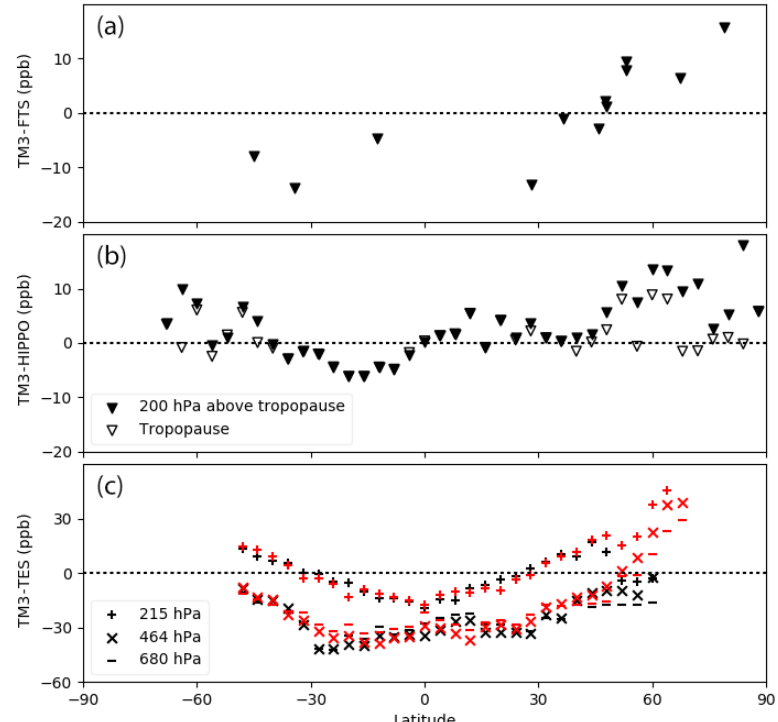
Figure 6. Comparisons of CH 4 with TM3 and (a) FTS, (b) HIPPO and (c) TES. In the case of HIPPO and FTS the tropospheric column- averaged CH 4 is compared, which is obtained from integration between surface and the tropopause (empty characters) or 200hPa above the tropopause shifted (solid characters, only in the HIPPO case). For TES CH 4 mole fractions at 215, 464, and 680hPa are compared with TM3 simulations in a region 110 ◦ W–150 ◦ E (black) and the region beyond it (red) separately. Both TM3 and the measurements are averaged during the HIPPO 1–5